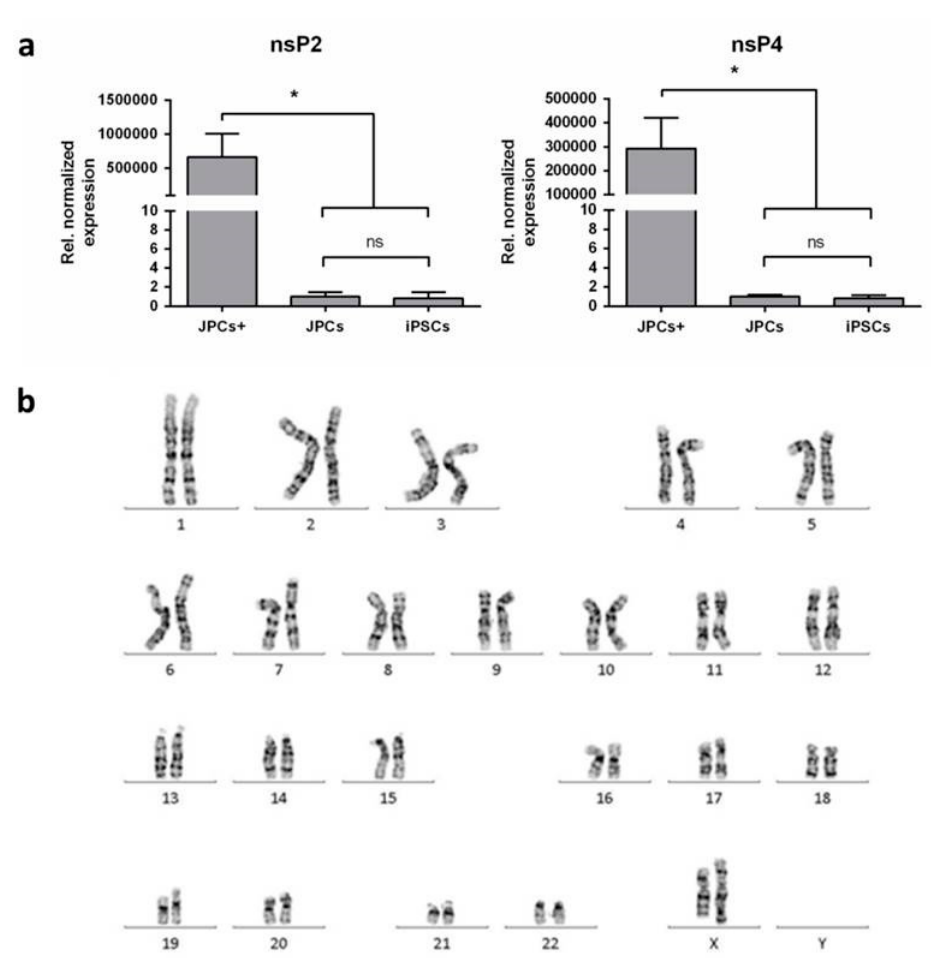
Figure 5. Elimination of srRNA after iPSC generation and karyotyping of JPC-derived iPSCs. ( a ) qRT-PCR analysis of nsP2 and nsP4 transcripts in iPSCs (passage 3), untreated JPCs and srRNA containing JPCs (JPCs+) 48 h post-transfection. Data are shown as mean + SEM. Differences were compared using one-way ANOVA ( n = 3, * p < 0.05, ns = not significant) ( b ) Representative karyogram of JPC-derived iPSCs showing a normal karyotype (46, XX).